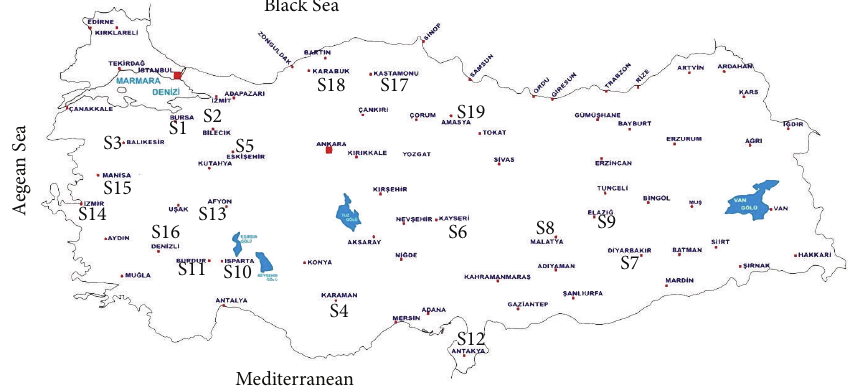
Figure 1: The location of the sampling sites of the sedimentary rocks in Turkey.